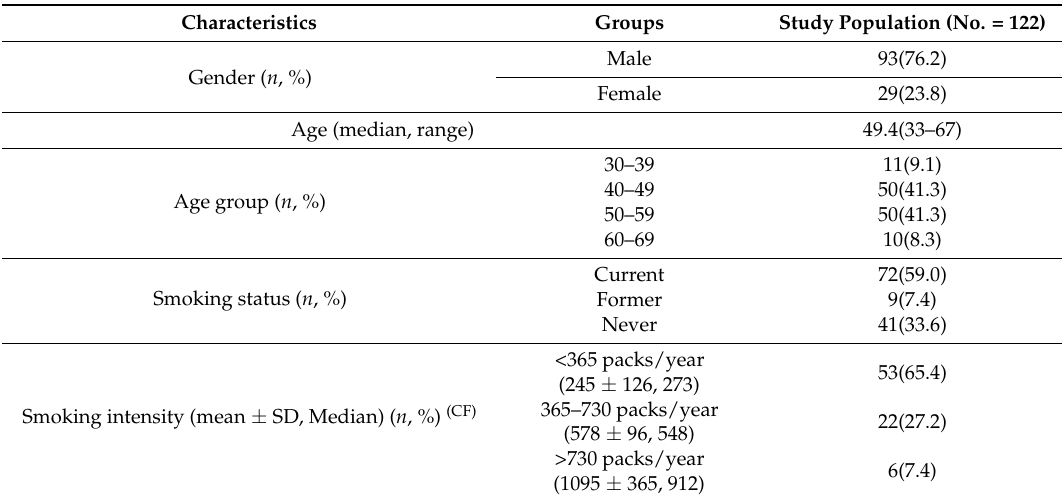
Figure 1. Top of the figure was a sample of exhaled breath, while bottom of the figure was the corresponding air sample. Three substance peaks were marked in the figure, where Peak 1 was cis -1,3,5-hexatriene (Chemical Abstracts Service (CAS) register No. 2612-46-6), Peak 2 was 2,5-dimethylfuran (CAS No. 625-86-5), and Peak 3 was decanal (CAS No. 112-31-2). Table 1. The characteristics of the study population.